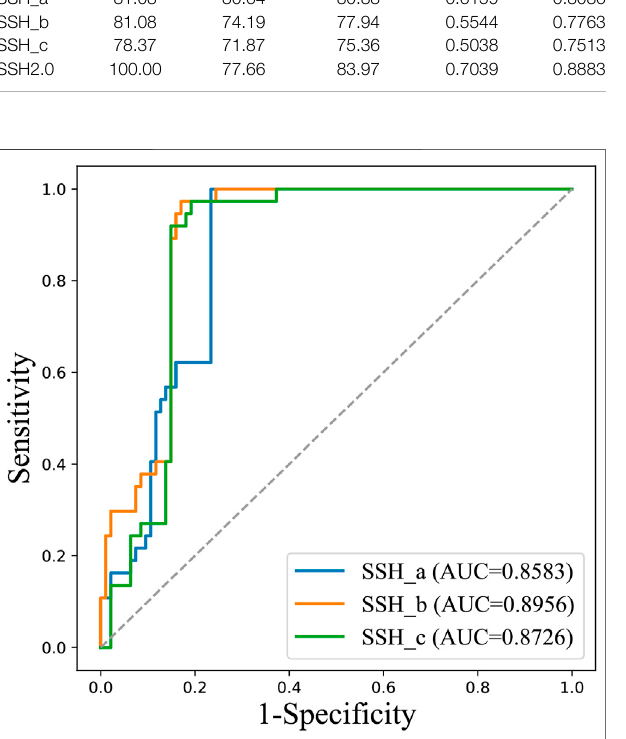
FIGURE 3 | The ROC curves of three sub-models for predicting all 131 antibodies.